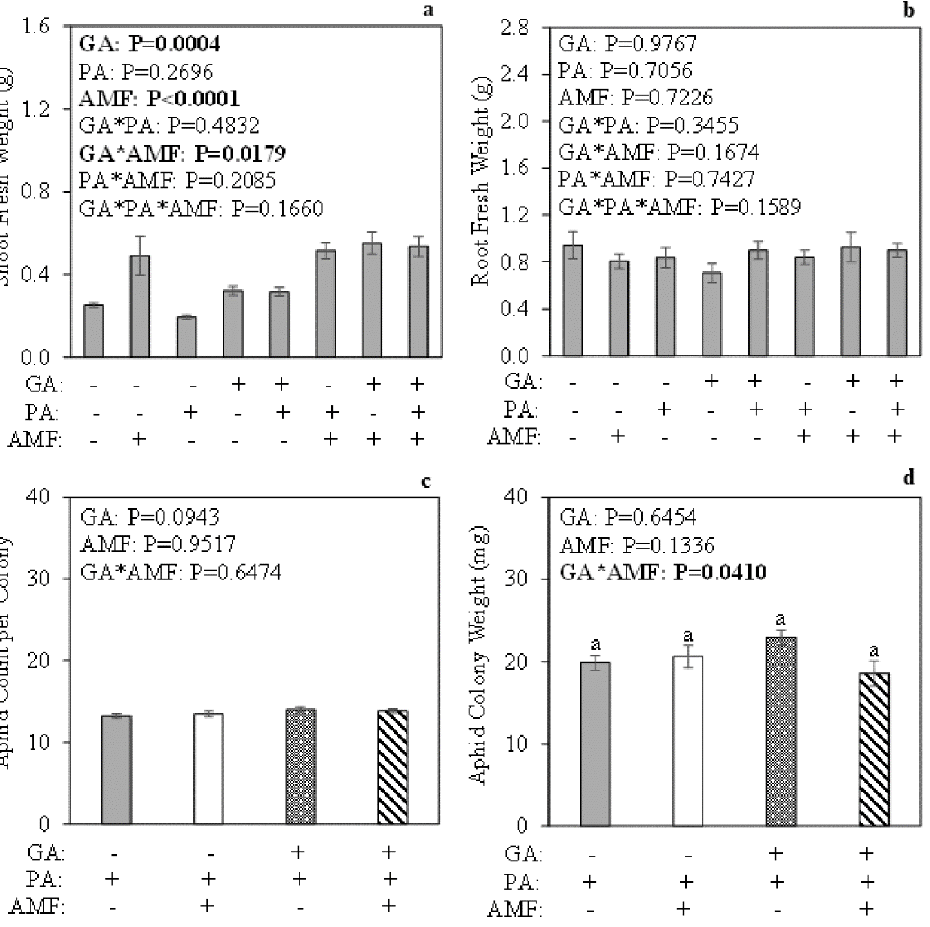
Figure 1. Impact of exogenous gibberellic acid (GA) application, 36 h of pea aphid ( Acyrthosiphon pisum ) (PA) feeding, and AM fungus ( Rhizophagus intraradices ) (AMF) root colonization on Medicago truncatula ( a ) shoot and ( b ) root growth. Impact of exogenous GA and AM fungus root colonization on ( c ) aphid count per colony and ( d ) aphid colony weight. Potted plants were grown in topsoil: sand mix for 44 days. Plants were harvested at 51 days post seed sterilization. Three-factor analysis using gamma distribution ( a ), three-factor ANOVA ( b ), two-factor analysis using Poisson distribution with scaled Pearson χ 2 ( c ), and two-factor ANOVA ( d ) were used. Values represent the mean ± SEM ( n = 7 or 8) per treatment. Different letters represent significant differences among groups using Tukey–Kramer post hoc tests ( p < 0.05).